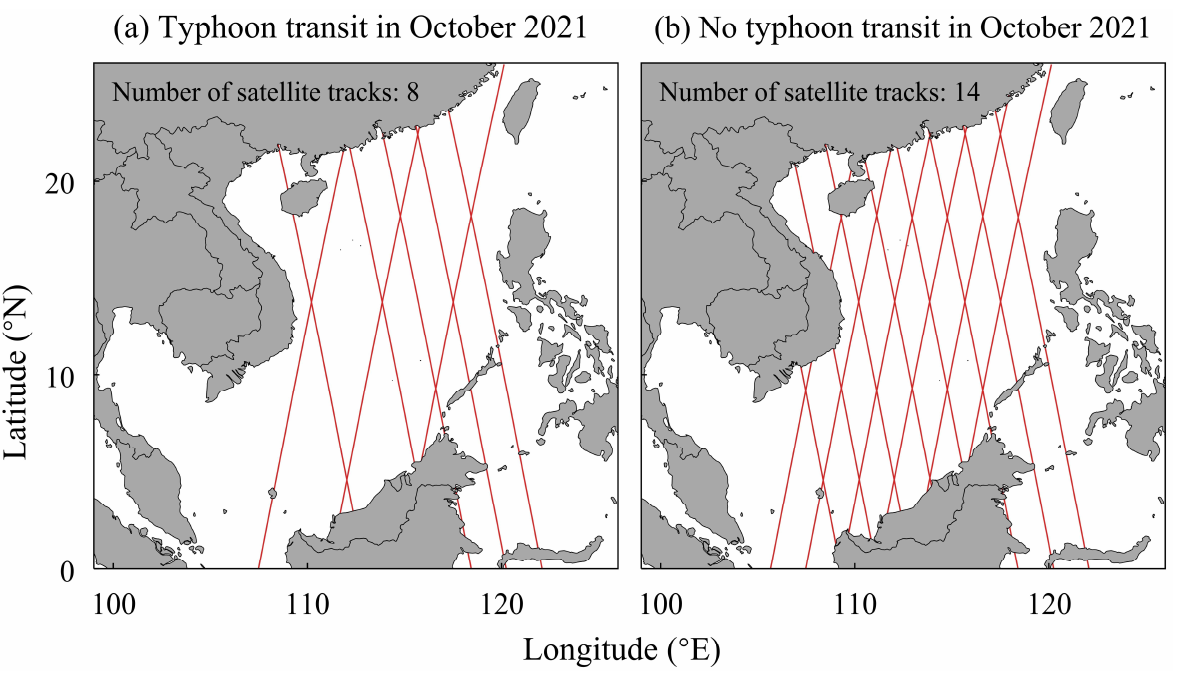
Figure 10. CFOSAT tracks typhoon transit and no typhoon transit of SCS in October 2021. The SWH from WWIII and Model C SWH were interpolated to the coordinates corre- sponding to the tracks data by the nearest neighbor method. The quality of the original SWH from WWIII data during typhoon and no typhoon were analyzed first (Figure 11a,b). Subsequently, we analyzed the accuracy characteristics of Model C in the 24-h SWH fore- casting during typhoon transit and no typhoon transit period by correlation and error analysis (Figure 11c,d). During typhoon transit, the CC of SWH from WWIII relative